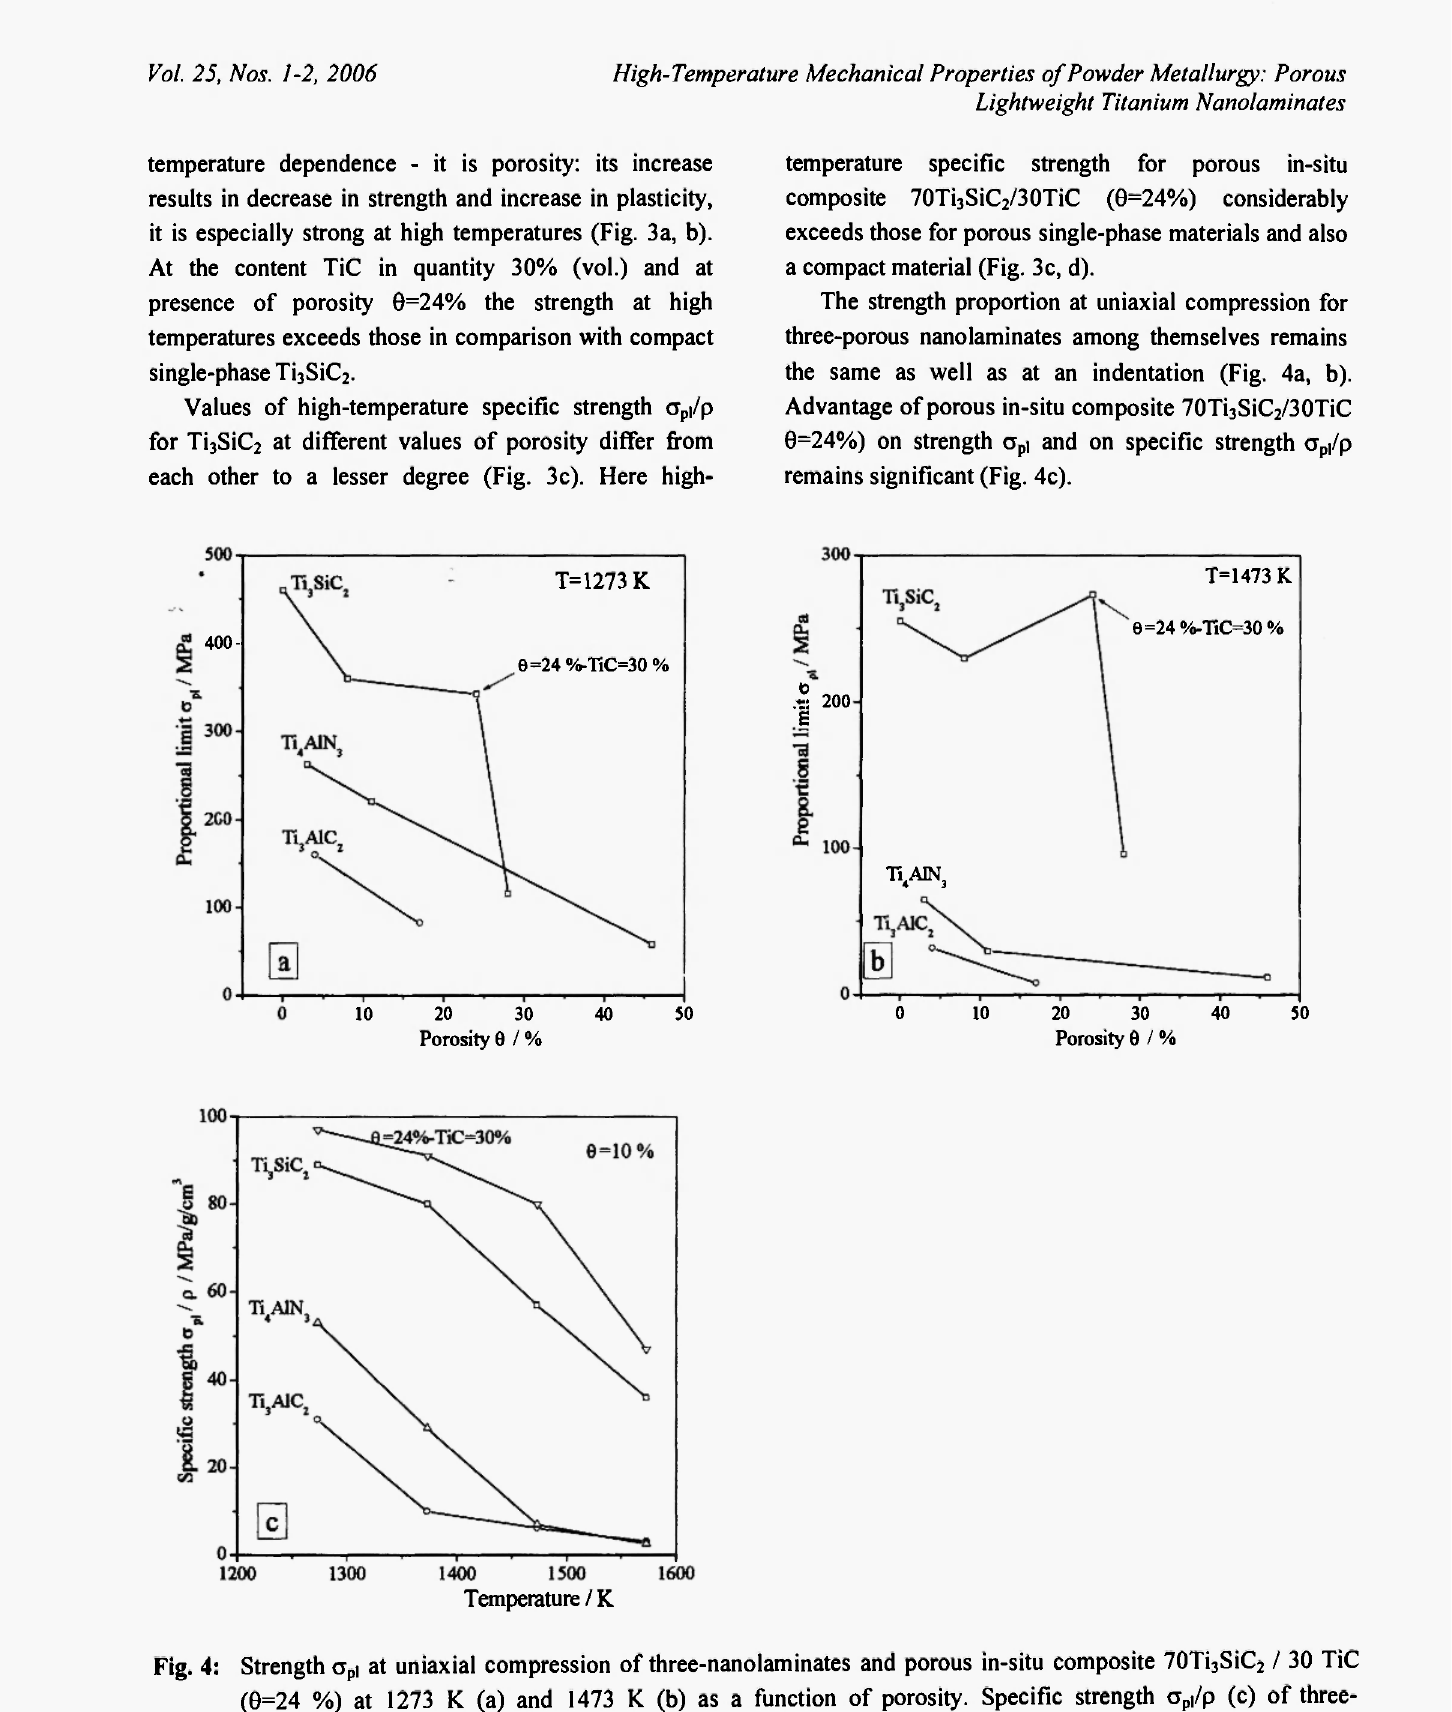
Fig. 4: Strength σ ρ ι at uniaxial compression of three-nanolaminates and porous in-situ composite 70Ti 3 SiC 2 / 30 TiC (0=24 %) at 1273 Κ (a) and 1473 Κ (b) as a function of porosity. Specific strength σ ρ ι/ρ (c) of three- nanolaminates (porosity 0=10 %) and porous in-situ composite as a function of